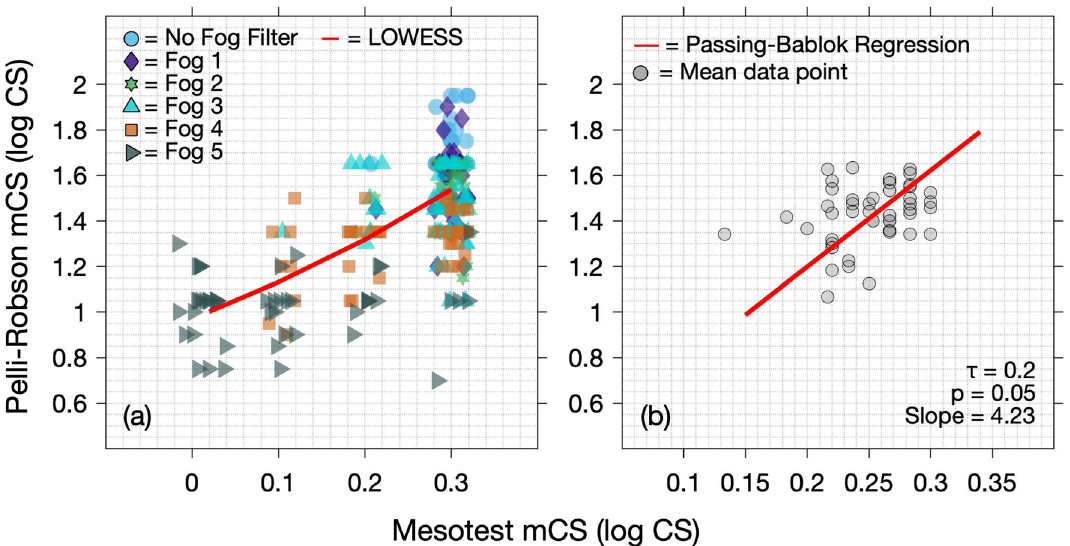
Figure 6. ( a ) LOWESS function (red line) to assess the relationship between mesopic CS as measured with the Pelli-Robson chart and Mesotest II at baseline and with all Fog filters; ( b ) a scatter plot of mean CS values across all Fog filter conditions for each participant with Passing–Bablok regression (red line) and Kendall’s tau correlation coefficient ( Ʈ